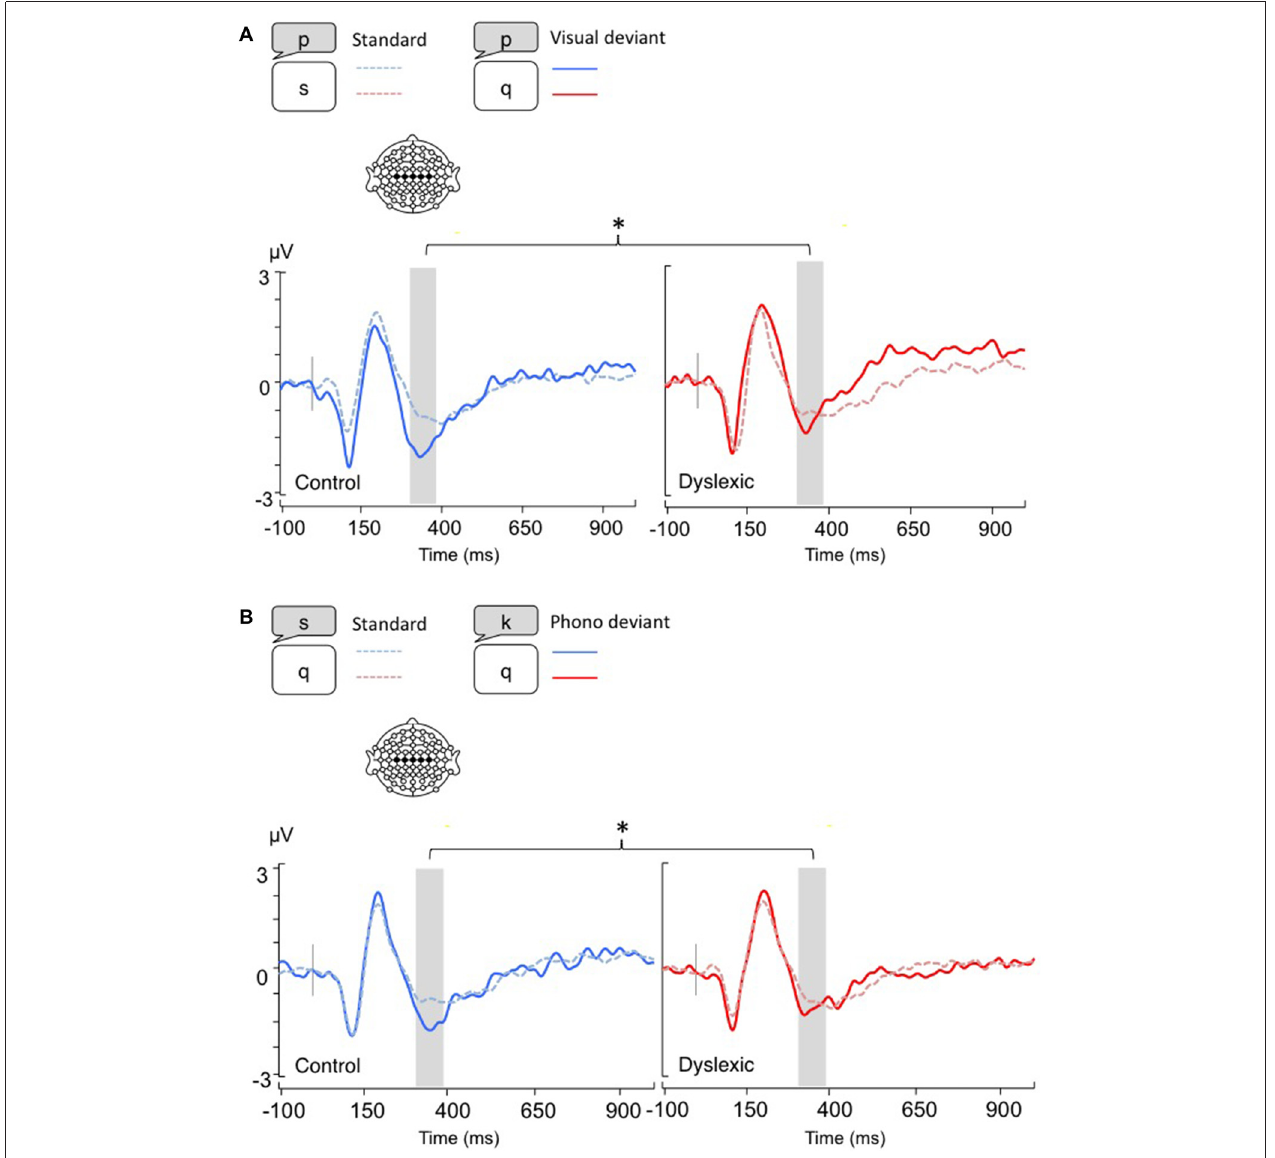
FIGURE 1 | Linear derivations over the electrodes where the phonological mismatch negativity (PMN) was maximal for typical and dyslexic readers in correct trials (Gray bar: analysis window). (A) Visual-orthographic deviants; (B) Phonological deviants. * p <